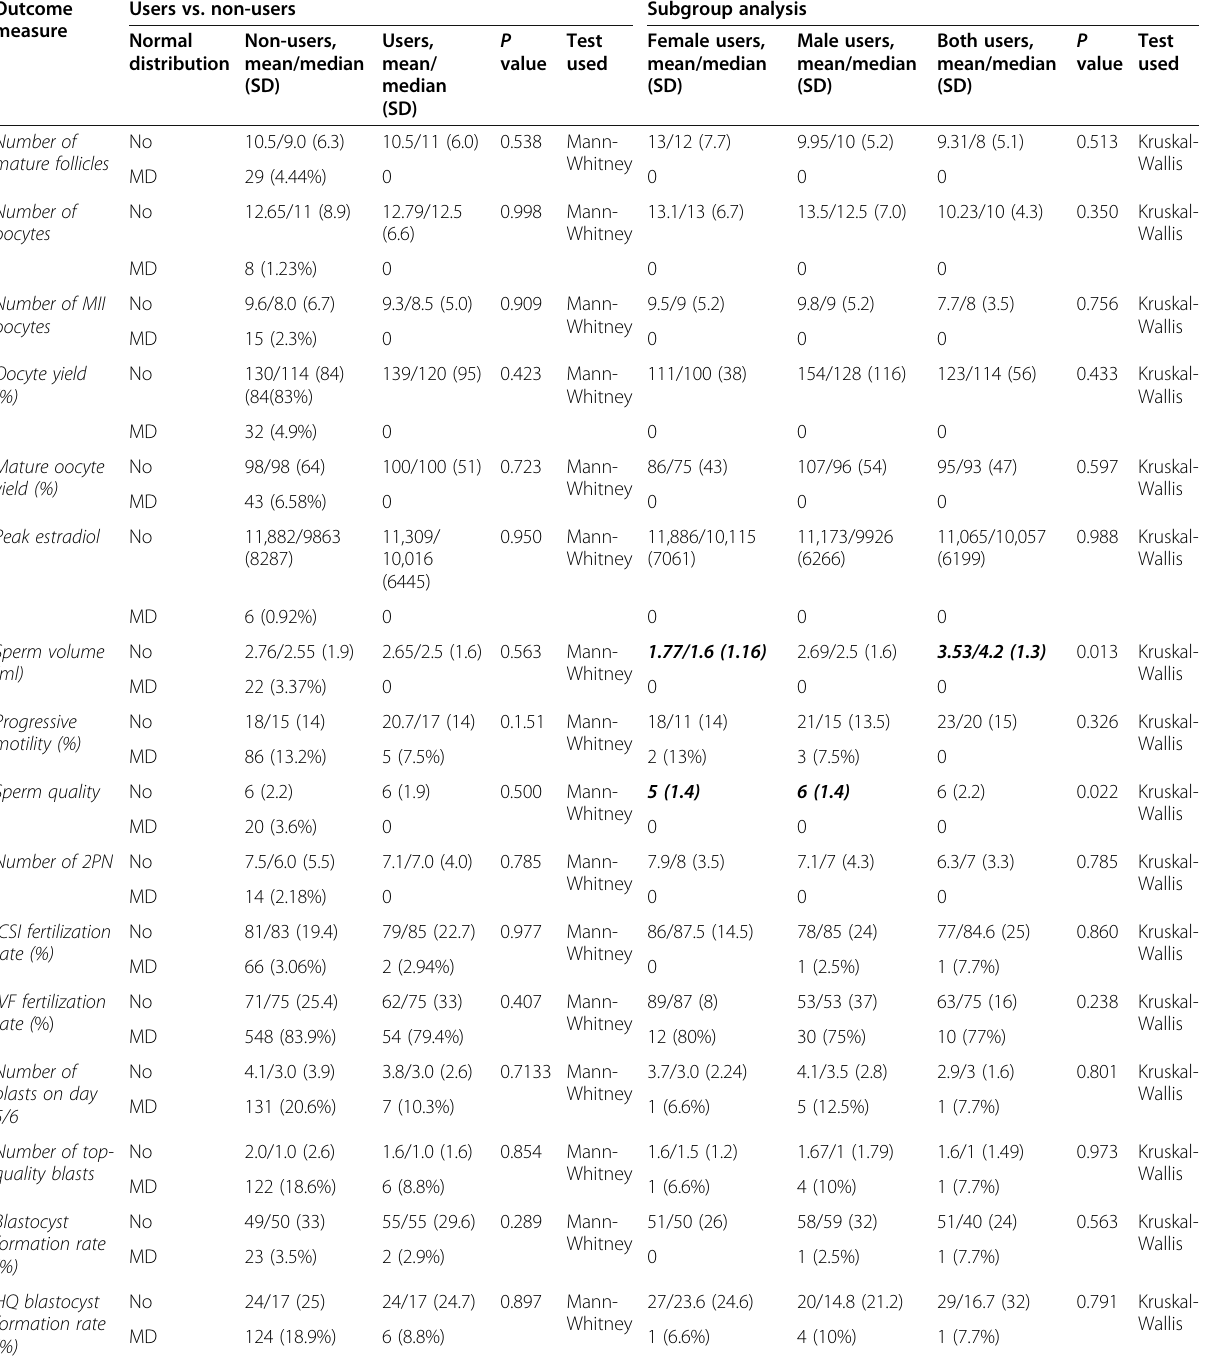
Table 2 IVF treatment characteristics of 722 IVF patients divided based on the level of cannabis use — mean, median, standard deviation, missing data, P value, and test used to compare the difference between cannabis users and non-users including a subgroup analysis of the user group according to the identity of the user (female partner, male partner, or both). Abbreviations: MII meiosis two oocyte-mature oocytes, 2PN 2 pronuclei oocyte/zygote/normally fertilized oocyte, ICSI intracytoplasmic sperm injection (a method for oocyte fertilization with a single sperm injected into its cytoplasm), IVF in vitro fertilization with insemination of oocytes with exposure to motile sperm as opposed to ICSI, Blsts blastocysts (the pre-implantation stage of embryo development), HQ high-quality. The left columns describe the comparison of users and non-users, and the columns on the right describe the comparison of users based on the gender of the